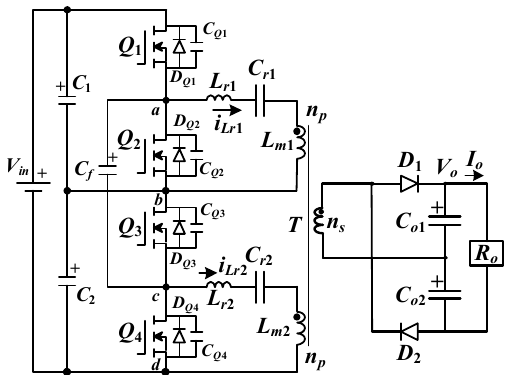
Figure 3. Proposed circuit schematic.